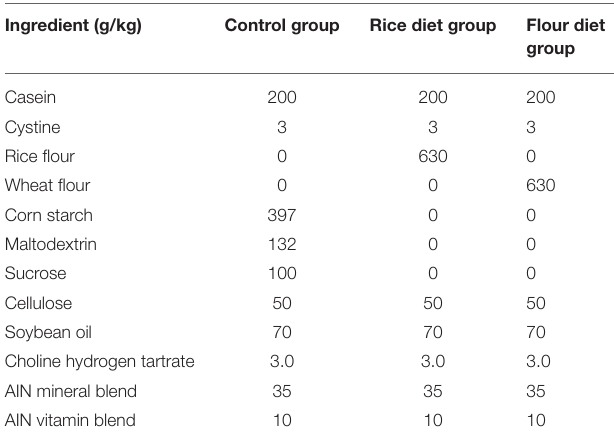
TABLE 1 | Three groups of feed